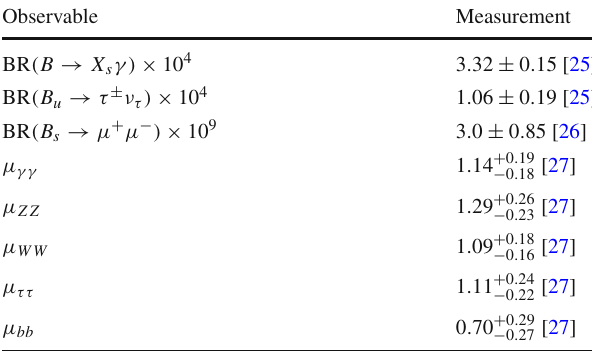
Table 1 Measured values of the B -physics observables and H obs signal rates imposed as constraints on the scanned